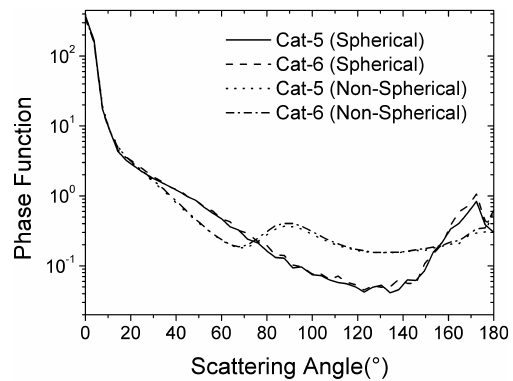
Fig. 7. Scattering phase functions for the dusty aerosol model (cate- gories 5–6) based on the assumption of spherical and non-spherical